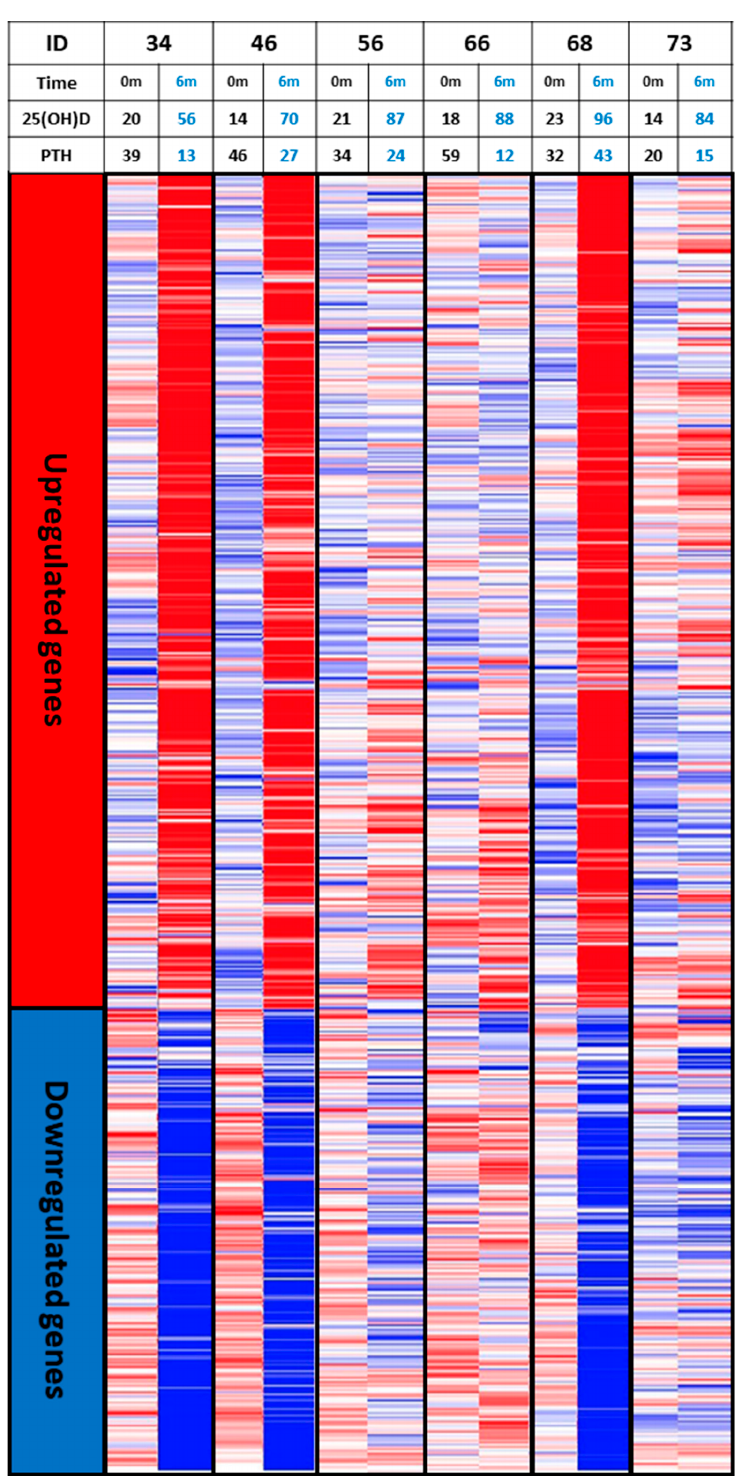
Figure 5. Heatmaps of vitamin D responsive genes whose expression response variation in 6 vitamin D-deficient subjects taking 10,000 international units per day of vitamin D 3 for 6 months showing that 3 subjects had a robust response in gene expression compared to the other 3 subjects who had minimum to modest responses even though these subjects raised their blood levels of 25(OH)D in the same range of ~60–90 ng / mL (150–225 nmol / L). Abbreviation: 0m: 0 month; 6m: 6 months; 25(OH)D: 25-hydroxyvitamin D; PTH: parathyroid hormone. Reproduced with permission from Holick MF, copyright